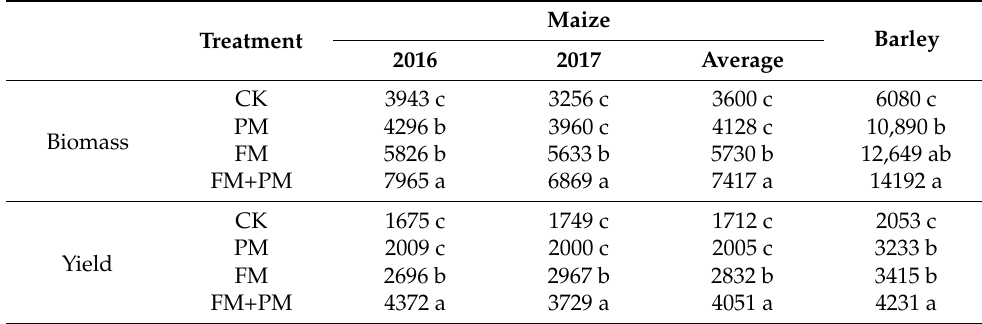
Table 4. Biomass (kg/ha) and yield (kg/ha) under different treatments during the 2016–2017 growing